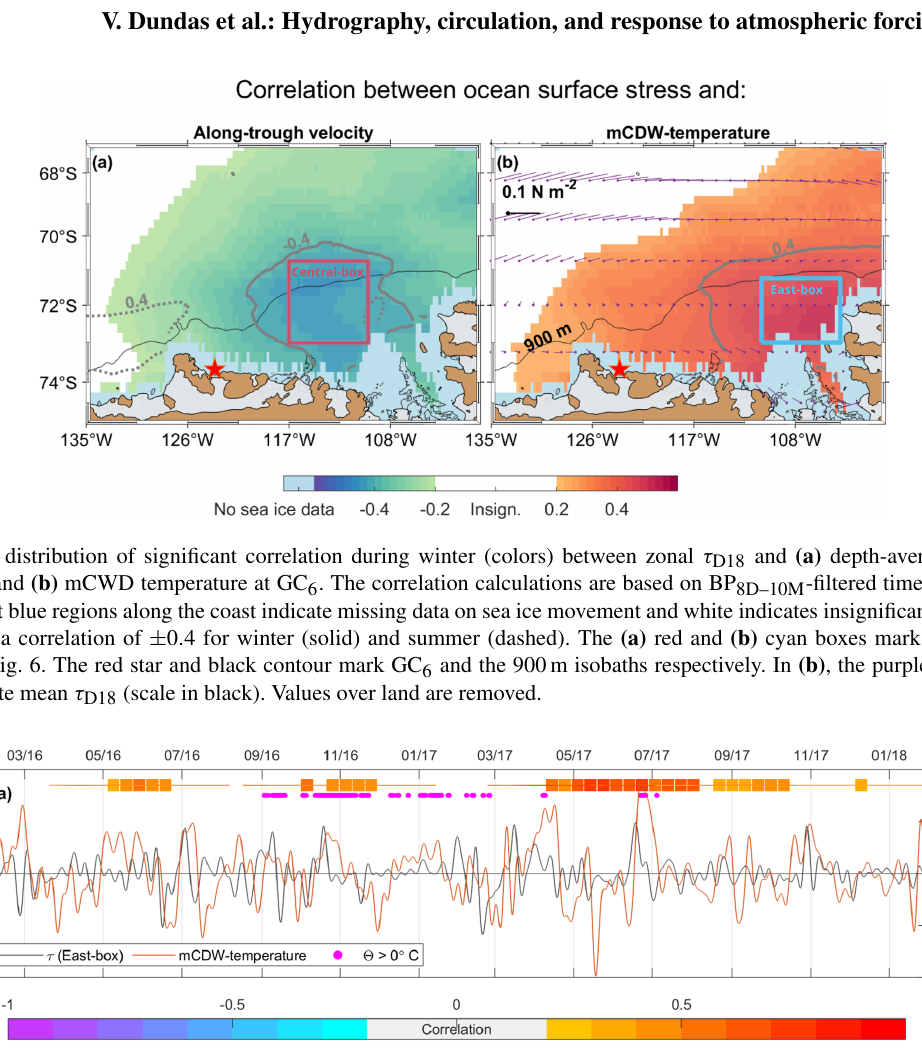
served depths is 3 . 7 ± 4 cm s − 1 toward the ice shelf, similar to the observed average